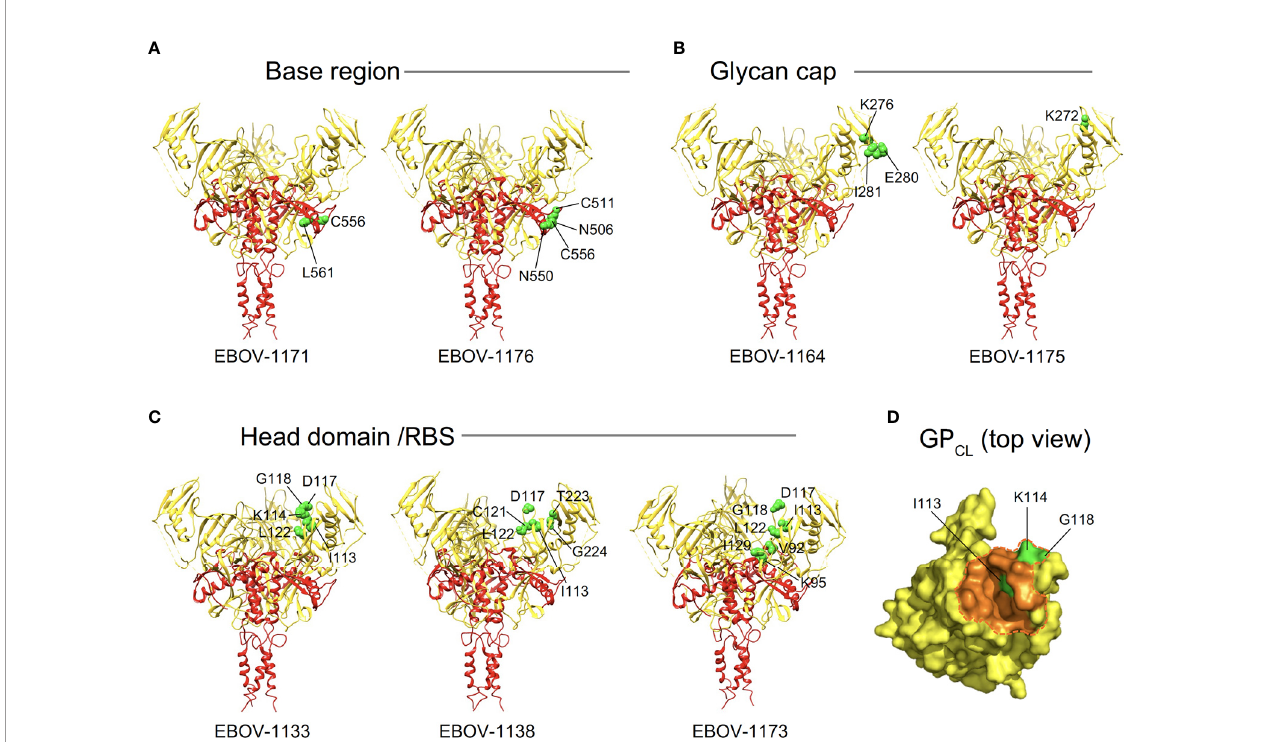
FIGURE 5 | Epitope residues of class representative plasma antibodies recognizing three major antigenic sites on EBOV GP. Amino acids and their positions for key binding site residues (green) are indicated for representative base-speci fi c (A) , glycan cap-speci fi c (B) , or head domain/RBS-speci fi c (C) antibodies and shown on a ribbon diagram of the EBOV GP trimer (PDB ID: 5JQ3) for one protomer. GP1 is in yellow, and GP2 is in red. (D) The NPC1 receptor binding site residues of the RBS (PDB ID: 5F1B) are shown in orange and NPC1 contact region is indicated within a dashed orange shape on GP CL (top view). RBS residues I113, K114, and G118 identi fi ed as critical for binding of head domain/RBS-speci fi c antibodies are shown in